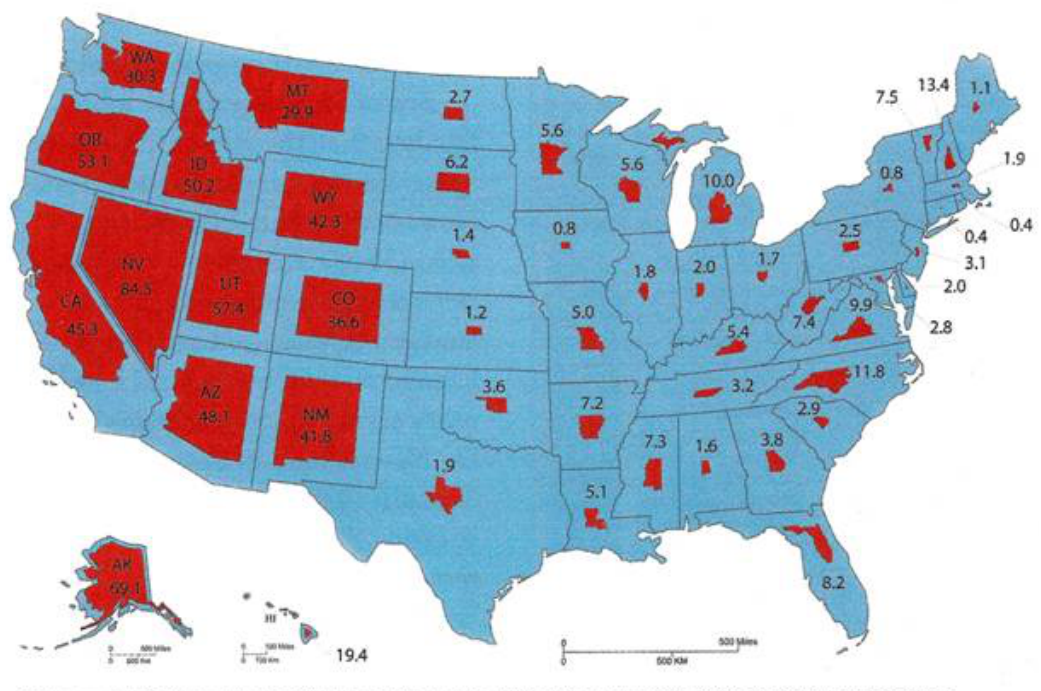
Figure 3. Public Land Percentages.